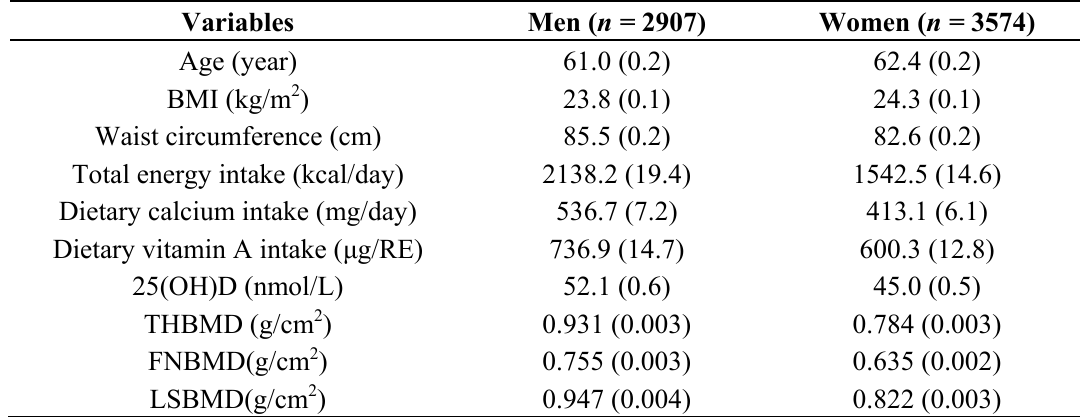
Table 1. General characteristics of study subjects by